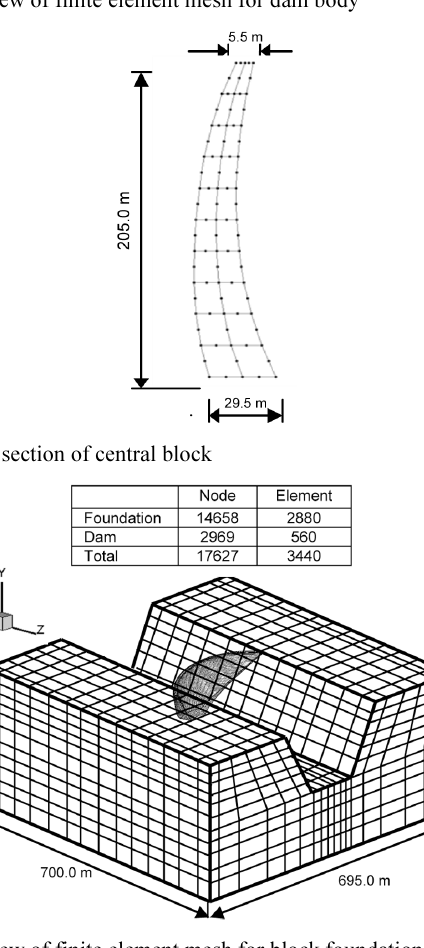
Fig. 4. Finite element modeling of Karun III RCC arch dam